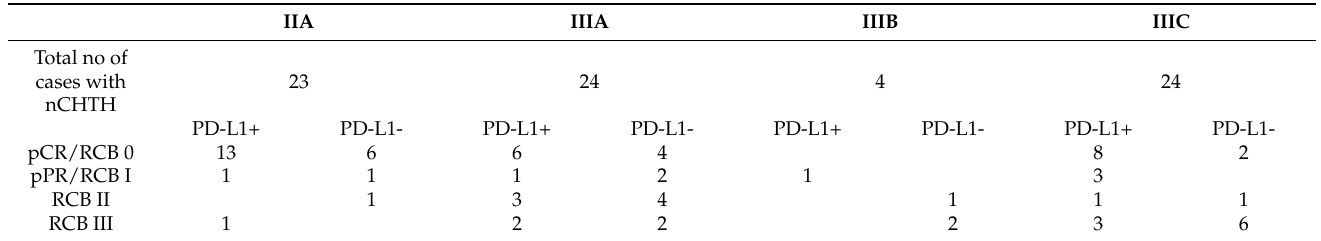
Table 2. PD-L1 status and pathological response to treatment of cases treated with neoadjuvant chemotherapy and surgery.